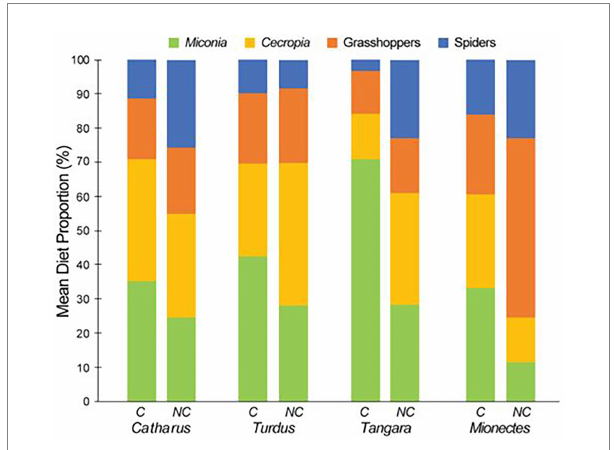
FIGURE 4 Mean diet proportions of potential prey types consumed by the four bird species in coffee (C) and forested non-coffee (NC) habitats.